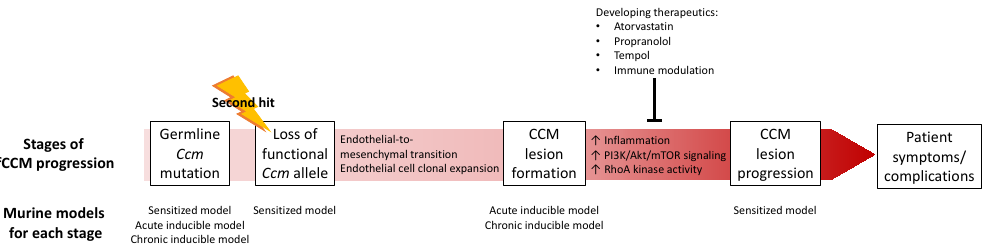
Figure 1. Schematic of CCM pathogenesis and the animal models best suited for studying processes of CCM disease.